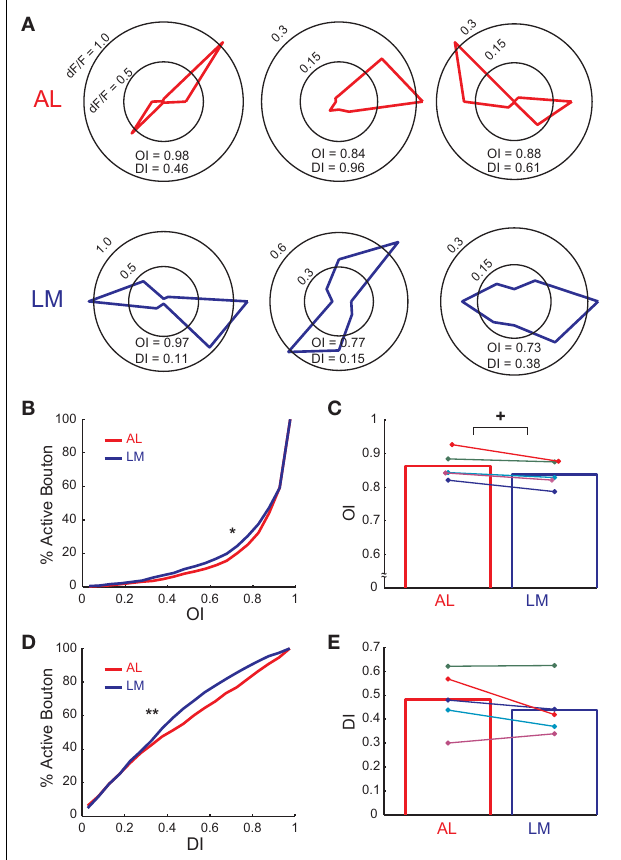
FIGURE 3 | Orientation and direction tuning property of axonal boutons in AL and LM. (A) Polar plots showing responses ( (cid:2) F/F) to eight directions for example axonal boutons in AL and LM. (B) Cumulative distribution of OI of axonal boutons in AL and LM. Mean OI across all responsive boutons = 0.851 and 0.829 in AL and LM, respectively. ∗ , P < 0 . 006. (C) Mean OI in AL and LM for each animal. Mean OI across animals = 0.864 and 0.838 in AL and LM, respectively. Each pair of colored dots indicates data from one animal. Bar graph shows mean of all the animals. + , P < 0 . 04. (D) Cumulative distribution of DI of axonal boutons in AL and LM. Mean DI across all boutons = 0.463 and 0.418 for AL and LM, respectively. ∗∗ , P < 0 . 0001. (E) Mean DI in AL and LM for each animal. Each pair of colored dots indicates data from one animal. Mean DI across animals = 0.481 and 0.438 for AL and LM, respectively. Bar graph shows mean of all the